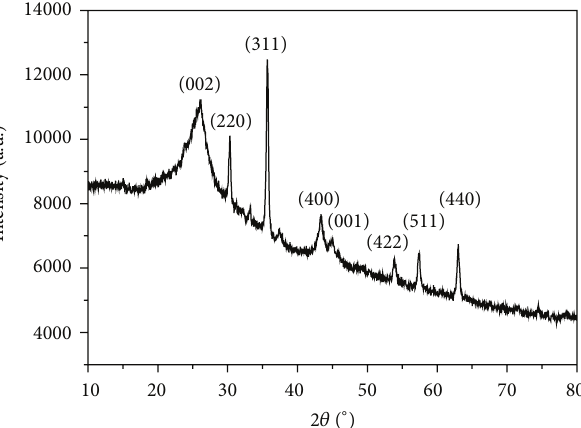
Figure 3: XRD patterns of as-obtained Fe 2 O 3 -CNFs as the function of pH